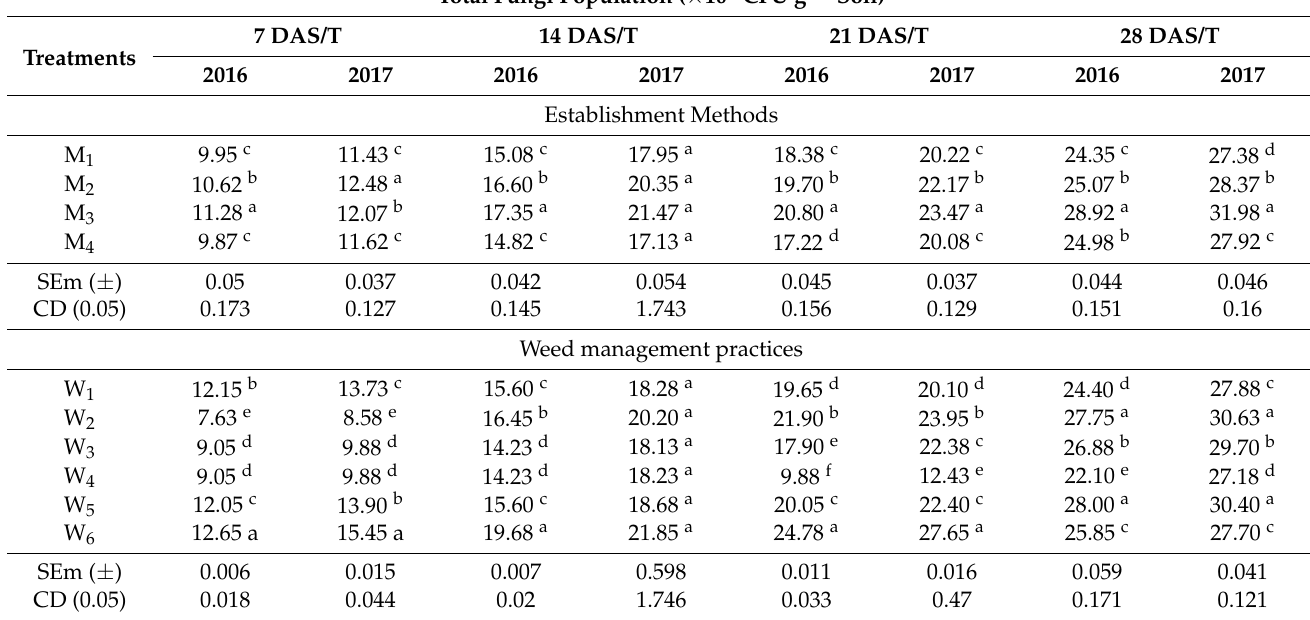
Table 4 may be referred to for treatment details. SE, standard Error, CD, Critical difference at 5% probability level. Different superscript letters indicate a significant difference between the